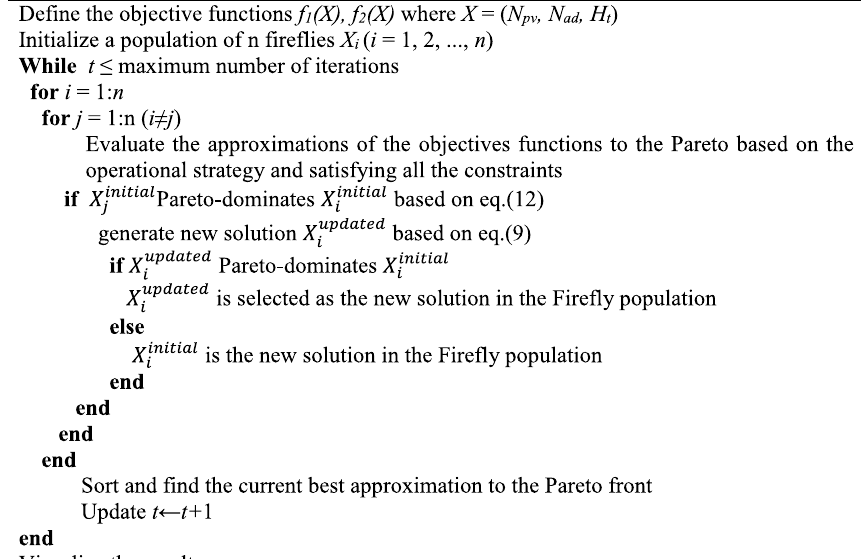
Table 3 Pseudo-code of the double-objective firefly